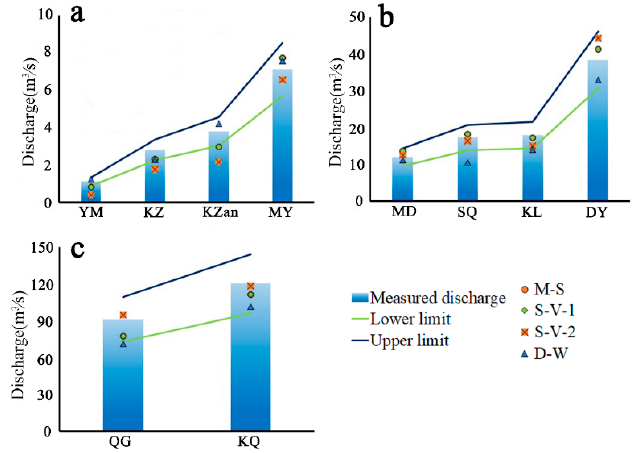
Figure 7. Discharge calculated using the four methods: ( a ) measured discharge < 10 m 3 ⁄ s; ( b ) 10 m 3 ⁄ s ≤ measured discharge <50 m 3 ⁄ s; ( c ) 50 m 3 ⁄ s ≤ measured discharge. Note: S-V = Saint-Venant; M–S = Manning–Strickler formula; D–W = Darcy–Weisbach equivalence.